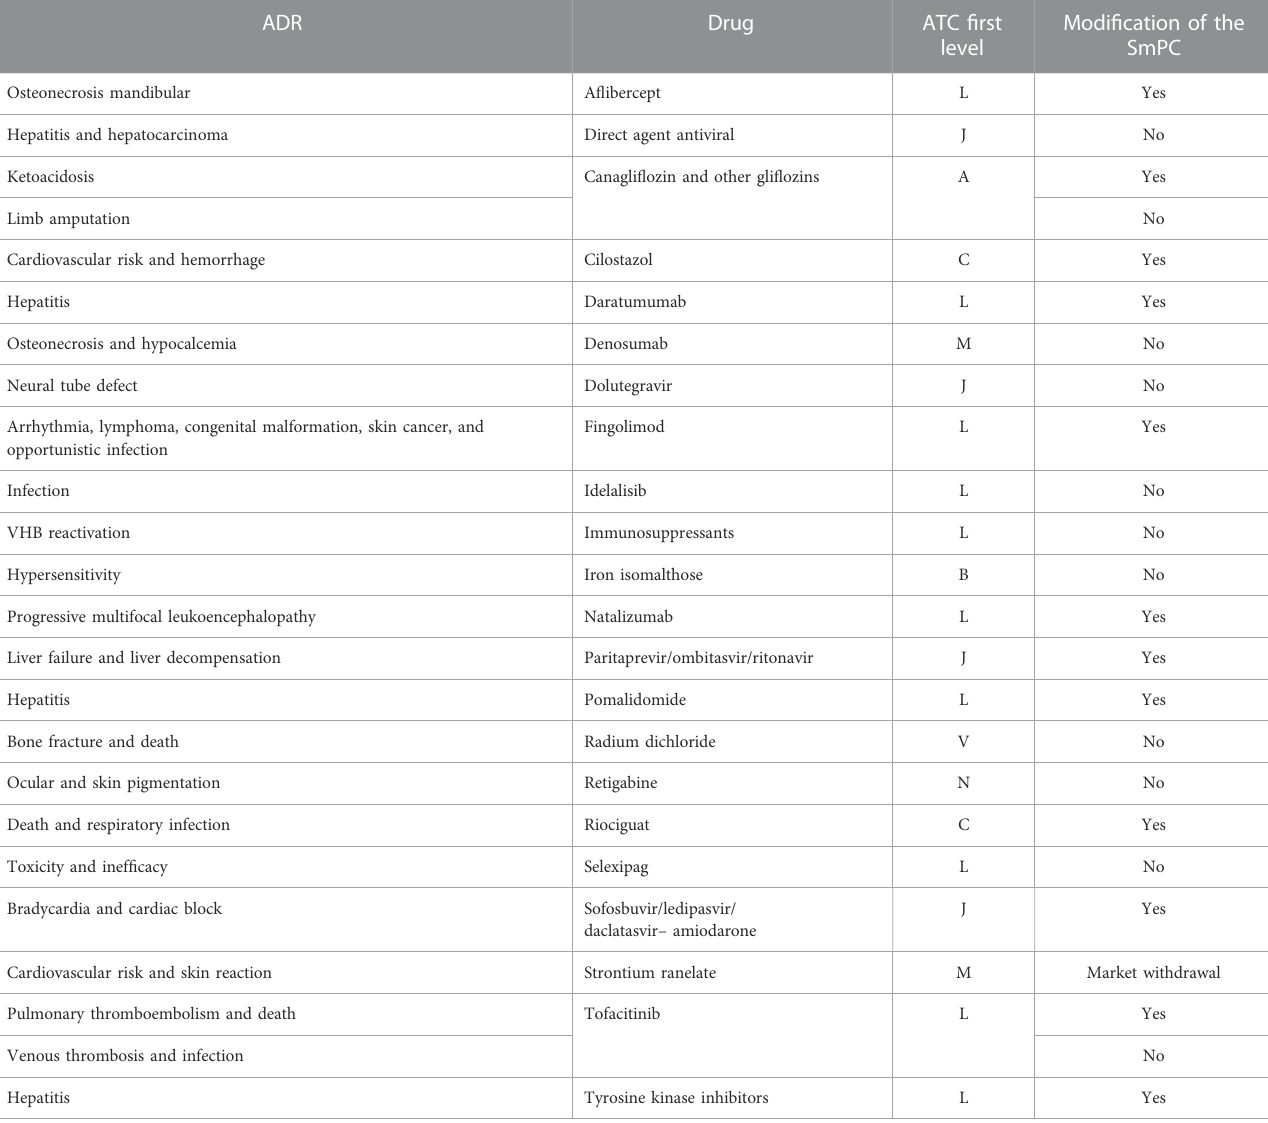
TABLE 5 Characteristics of alerts for drugs under ‘ additional monitoring. ’